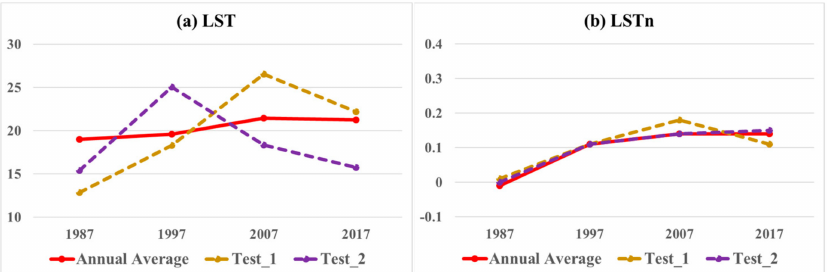
Figure 6. Comparison of original LST and LSTn in temporal analysis with input of di ff erent seasonal